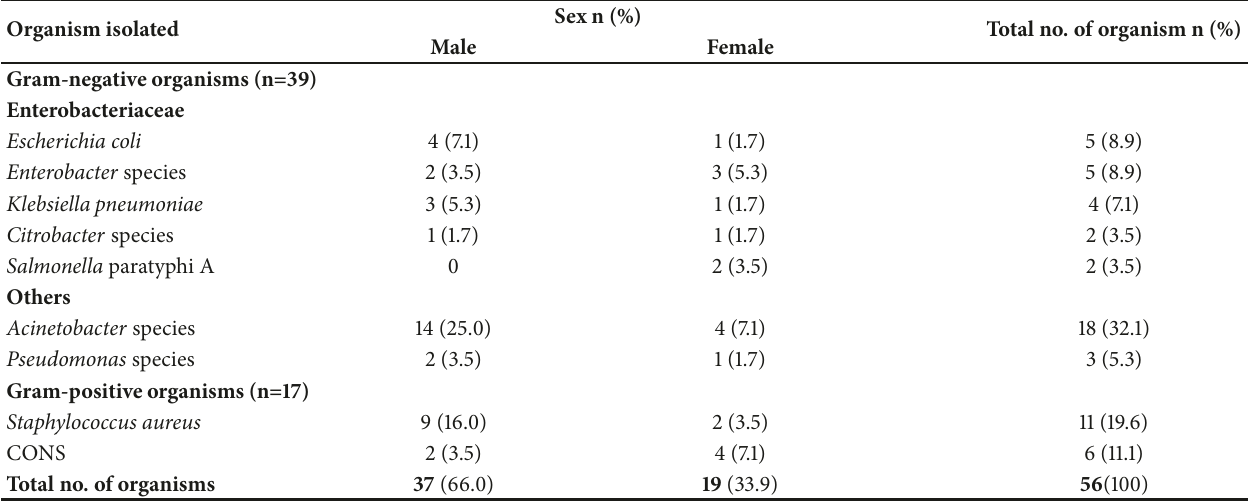
CONS : coagulase negative staphylococci . Figure in parenthesis indicates